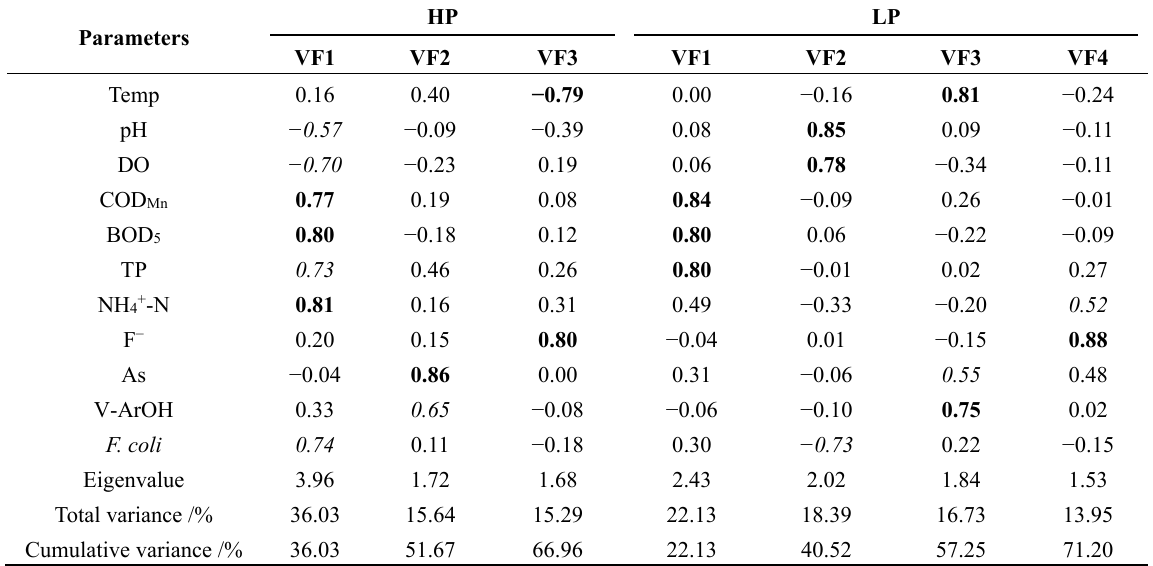
Cumulative variance